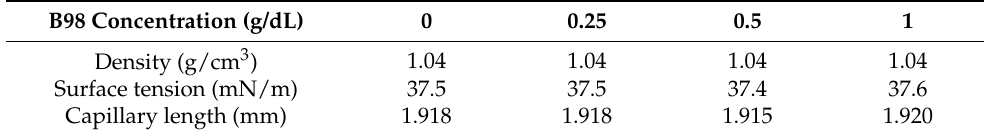
Table 2. Density of B98-benzyl alcohol